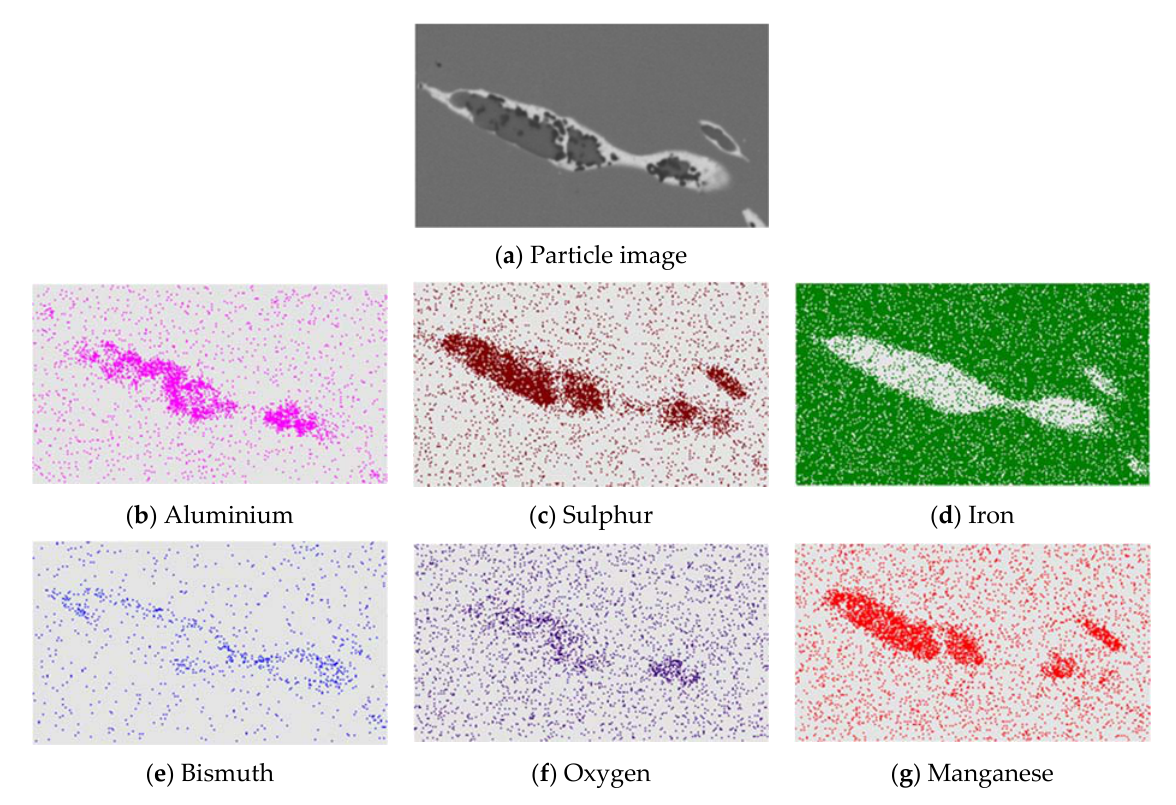
Figure 13. EDS mapping—distribution of individual elements ( b ) Aluminium, ( c ) Sulphur, ( d ) Iron, ( e ) Bismuth, ( f ) Oxygen, ( g ) Manganese in a ( a ) complex particle with Bi, in CMnCr steel with 0.12 wt. % Bi.